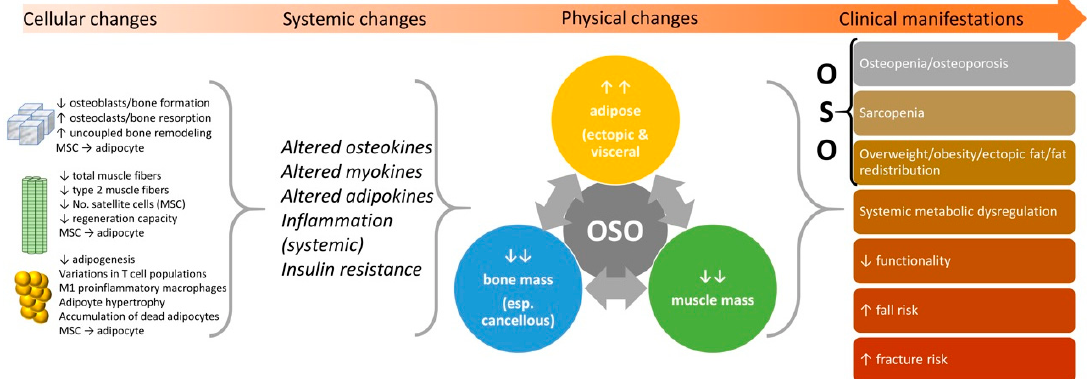
Figure 1. The progress of osteosarcopenic obesity (OSO) from cellular changes to clinical manifestations. Adapted from References [1,13–18]. No need for copyright.